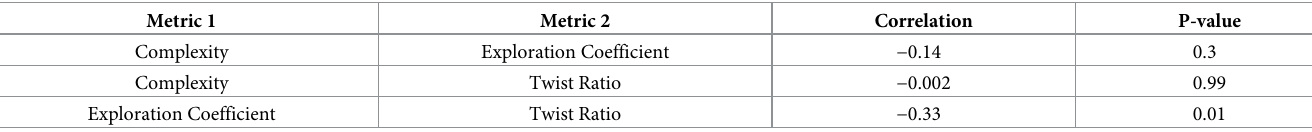
Table 2. The spearman correlation among the metrics discussed in previous sections and their